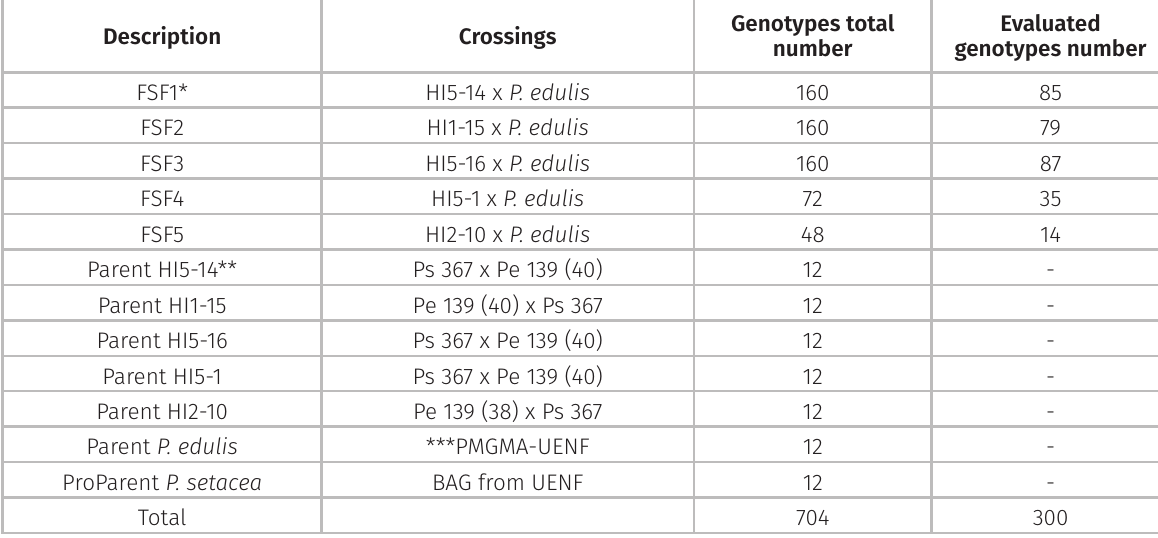
Table I. Study populations origin and identification of composed of full-sib families (FSF), interspecific hybrids (IH), P. setacea and P. edulis , and genotypes distribution on the experimental area. Campos dos Goytacazes, RJ, 2017.